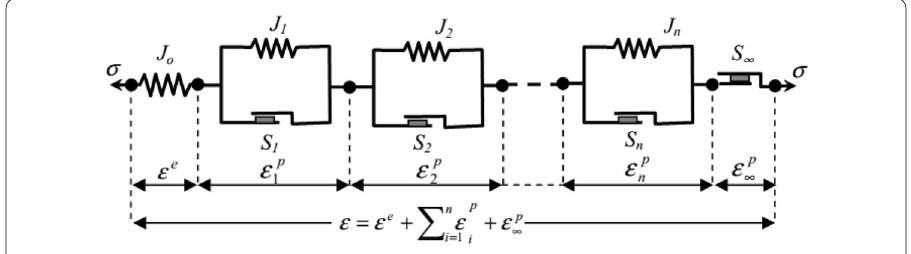
Fig. 2 Multiple surface